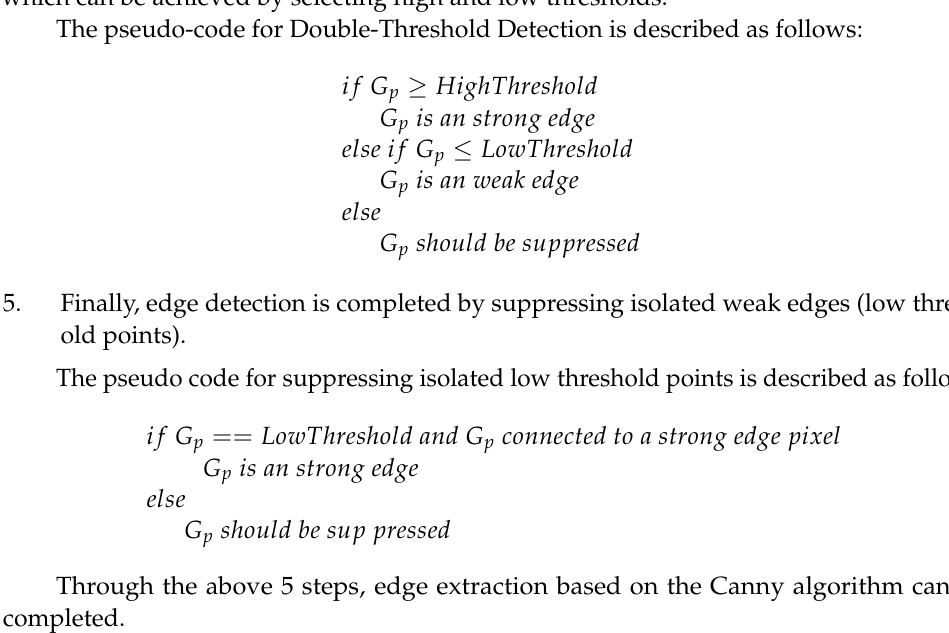
Figure 13. The effect of contour detection and edge detection. ( a ) is obtained from Figure 12 by the size of the area of the detected contour. ( b ) The effect from ( a ) by the edge detection of Canny oper- ator. 2.5.3. Tilt Correction Hough transform is a feature extraction technique whose purpose is to find instances of objects with specific shapes through the voting process in the parameter space [38]. The basic principle of the Hough transform is to use the duality of point and line to change the given curve in the original image space into a point in the parameter space through the curve expression. Polar coordinate parameters (𝜌, 𝜃) are used to represent a straight line, where 𝜌 is the length of the line segment, and 𝜃 is the angle between the line and the 𝑥 axis. To explore the (𝜌, 𝜃) parameter space, the first step is the creation of a two-